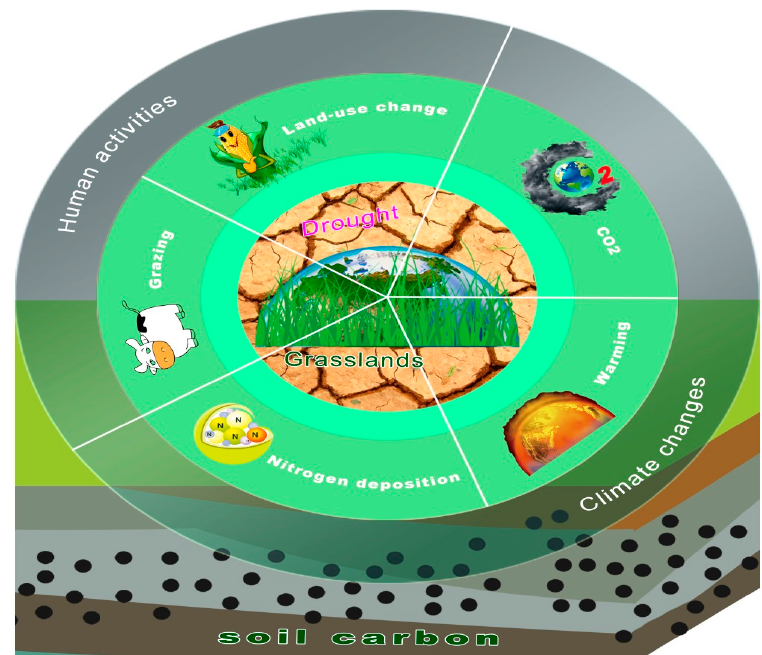
Figure 1. The schematic diagram describes the complex interaction between drought and global change drivers on grassland C cycling. In the paper, global change drivers include elevated CO 2 concentrations, global warming, N deposition, grazing, and land-use changes. To some degree, the chronic and gradient factors can counteract the negative effects of drought on grassland C cycling via their positive effects driven by climate change, such as elevated CO 2 concentrations, global warming, and N deposition; on the other hand, the periodic and pulsing factors can amplify the negative effects of drought on grassland C cycling via human activities such as grazing and land-use change. In grasslands, the ecosystem has the ability to buffer impacts from drought and large amounts of soil C in its surface layers. As climate change and human activities continue, droughts will have a stronger and more complicated effect on C cycling in grassland ecosystems in the future.